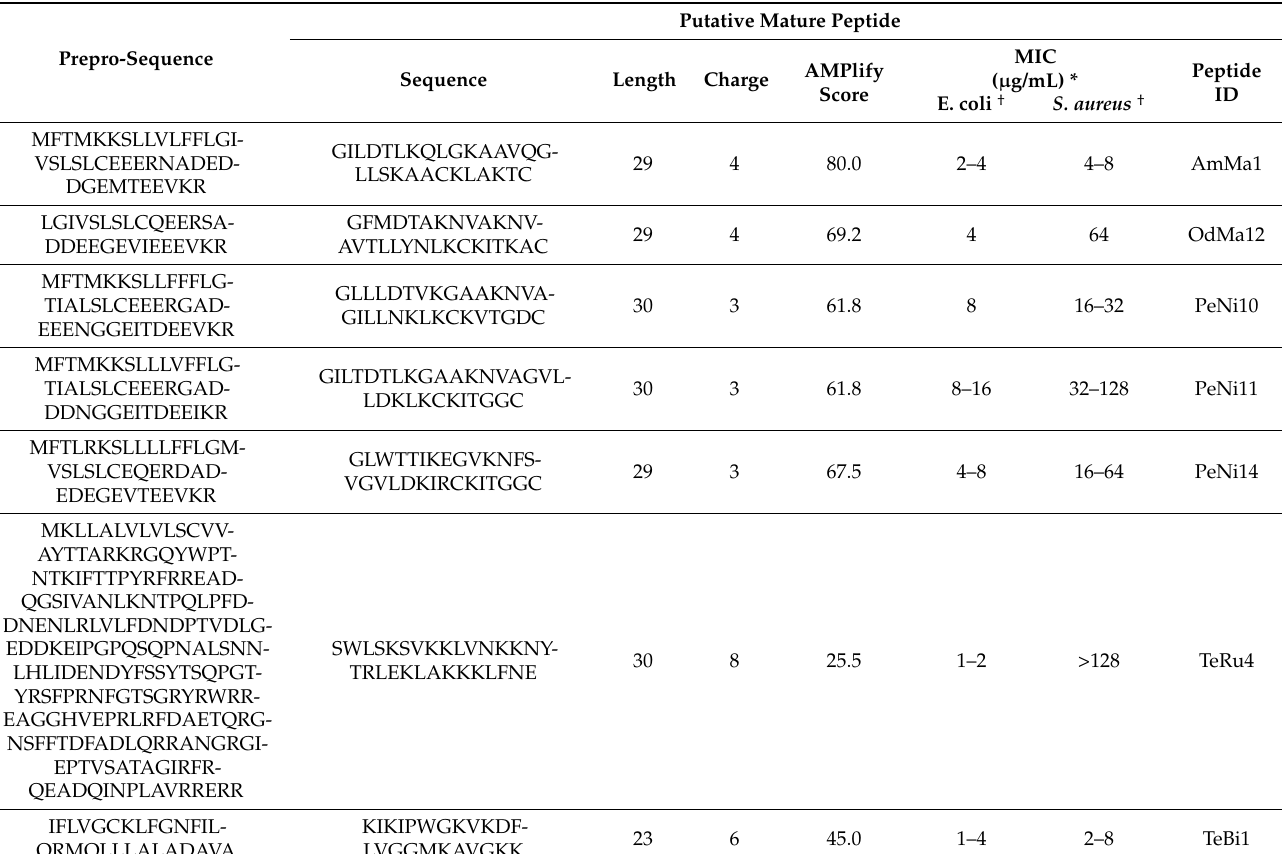
Table 1. Characteristics of putative AMP sequences with moderate to high in vitro bioactivity against E. coli or S. aureus . Each sequence is separated into the prepro sequence and the predicted mature peptide sequence. Conserved proteolytic cleavage sites are underlined in the prepro